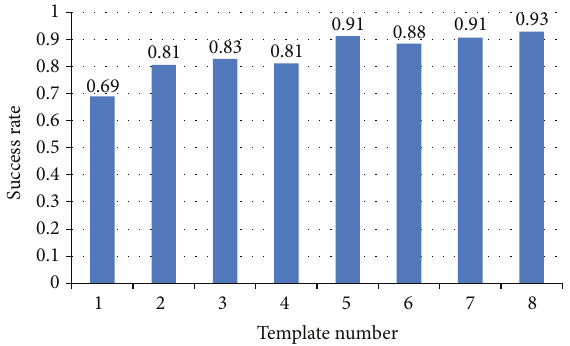
Figure 3: Maximum 𝑅 prior success